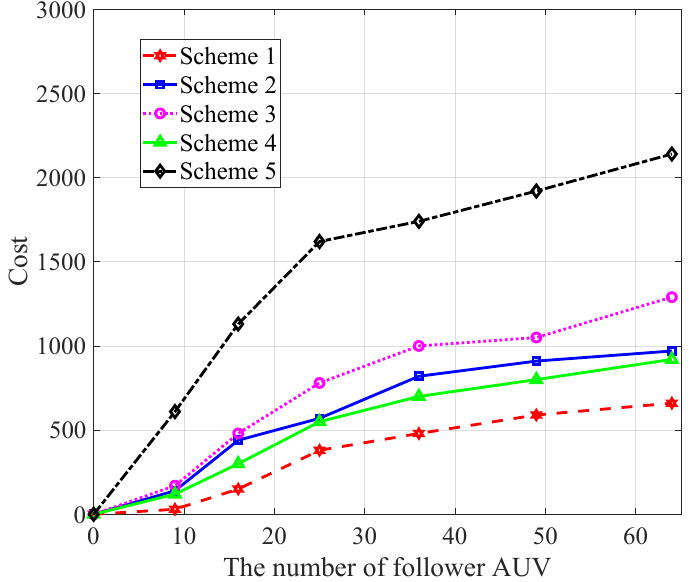
Figure 6. Comparison of the costs of different schemes versus β .